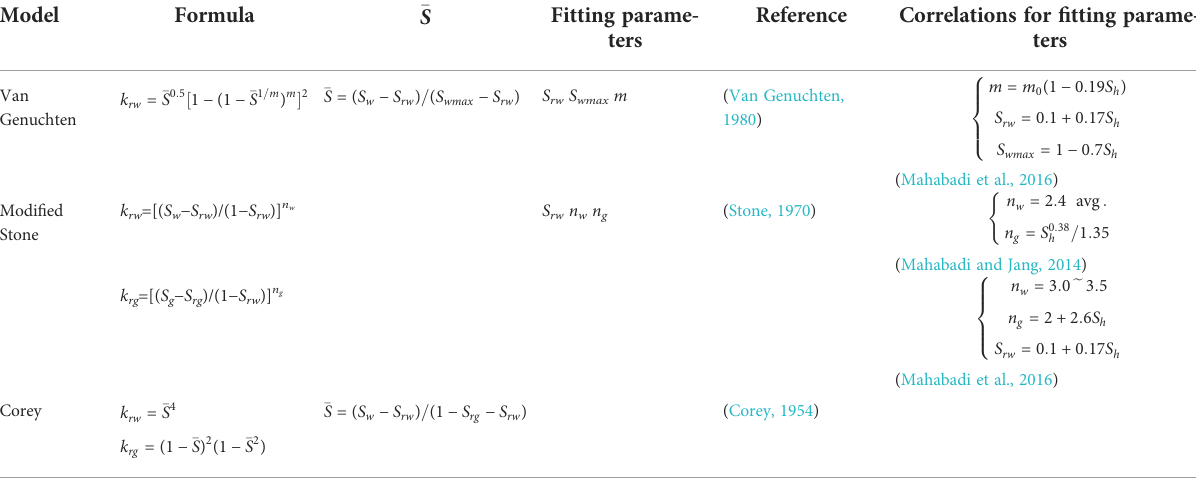
TABLE 2 Relative permeability models applied in marine sediments and corresponding correlations for fi tting